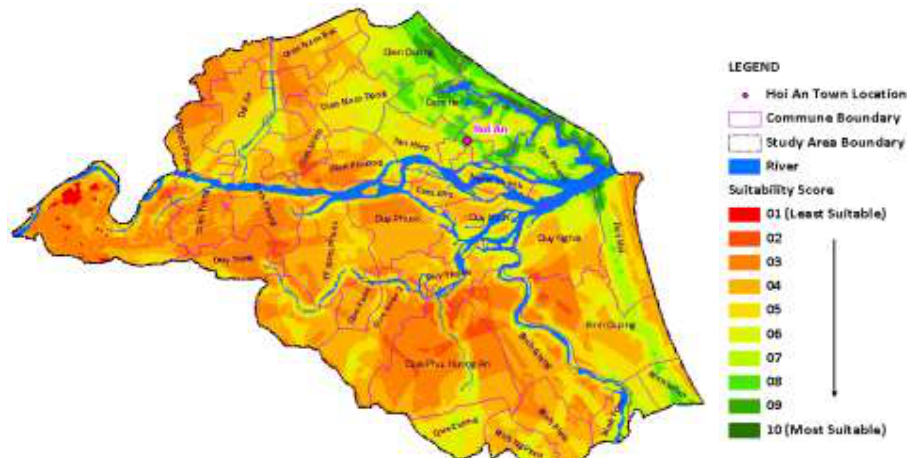
Figure 3. Land Suitability Map for Tourism Development in Hoi An, Vietnam (Source: Pareta, 2013)